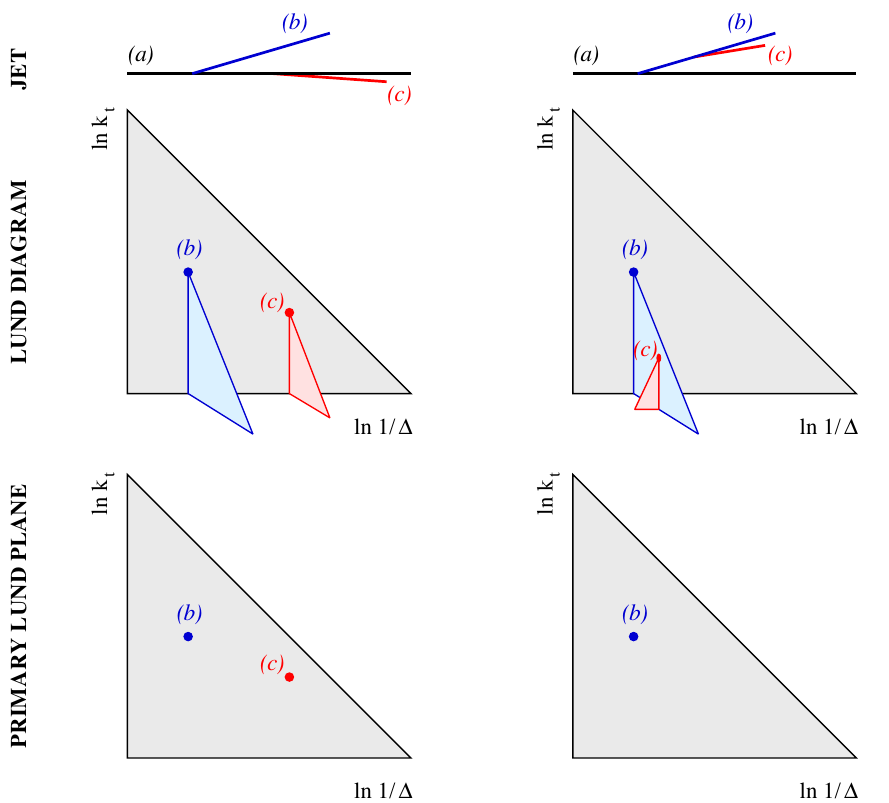
Figure 1. Di(cid:11)erent representations for two jets. Top: the particles inside the jet. Middle: the full Lund diagram. Bottom: the primary Lund plane. See text for further